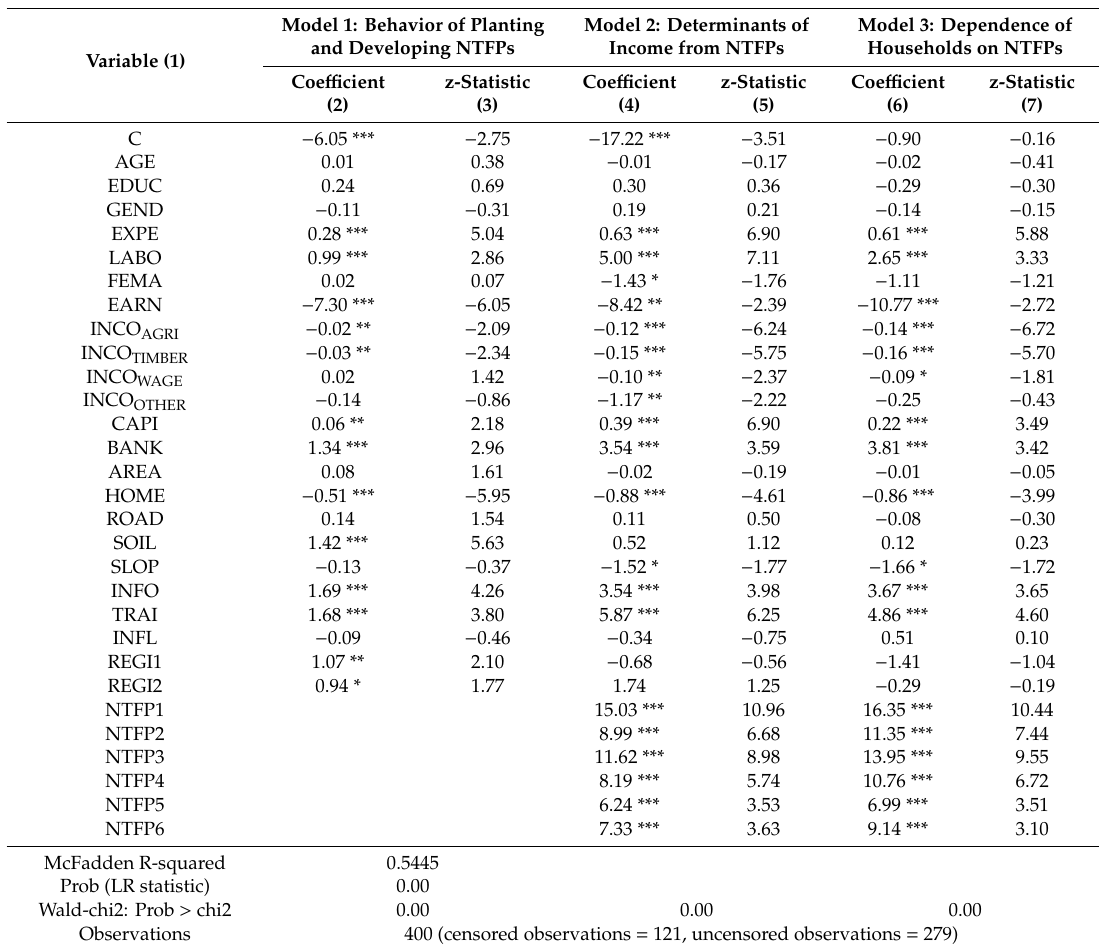
Table 2. Model estimation